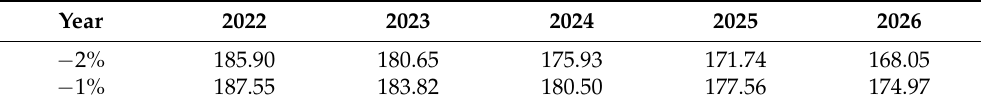
Table 25. Prediction result of water requirement with different growth rates of AVSI in Inner Mongo- lia.